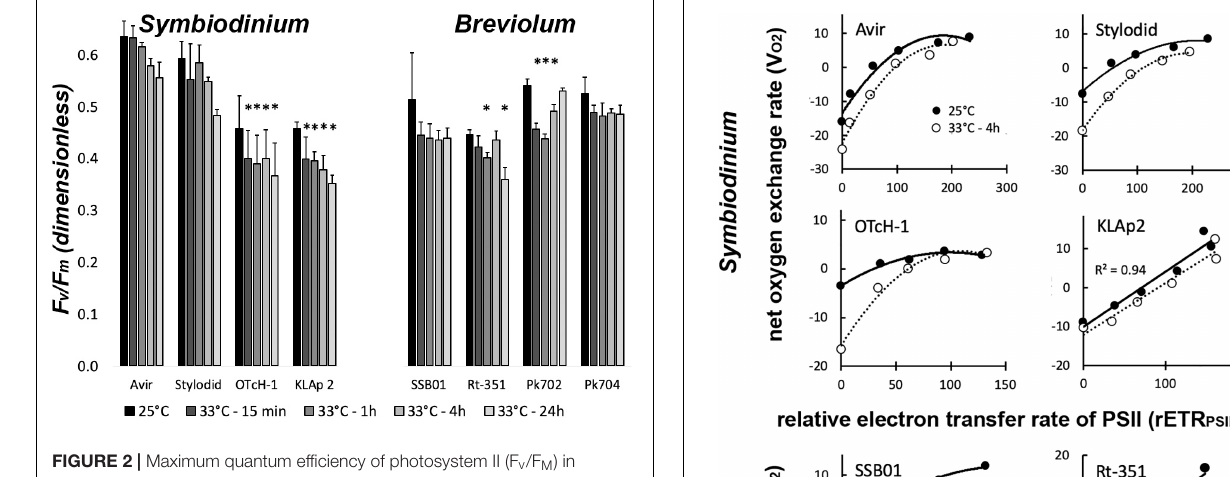
FIGURE 2 | Maximum quantum efficiency of photosystem II (F v /F M ) in Symbiodinium and Breviolum strains upon short-term thermal stress (33 ◦ C) under continuous light. Samples were analyzed at time 0 (25 ◦ C), after 15 min, 1 h, 4 h and 24 h at 33 ◦ C. All measurements were performed on three independent biological replicates and data are presented as means ± SD. ∗ value differs significantly ( P < 0.05) from the control value at 25 ◦ C.